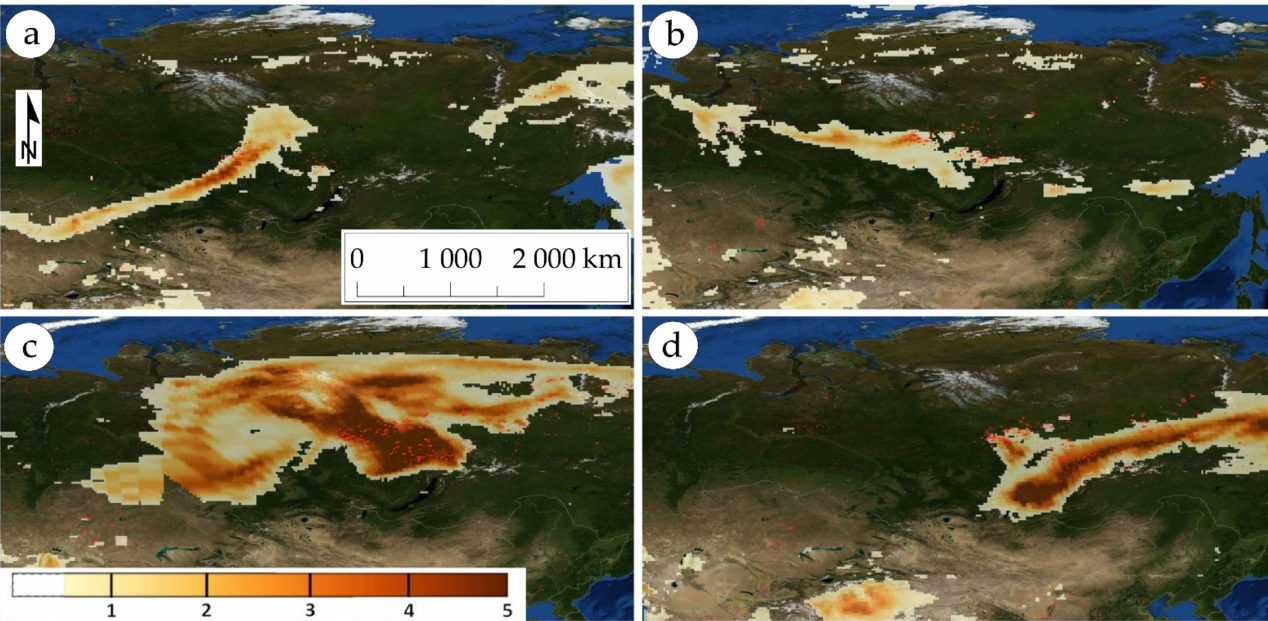
Figure 6. Aerosol Index data for Siberia in the summer of 2019 available from the OMPS Nadir-Mapper instrument on the Suomi National Polar-orbiting Partnership (Suomi NPP) satellite: ( a ) 14 July; ( b ) 19 July; ( c ) 24 July; ( d ) 29